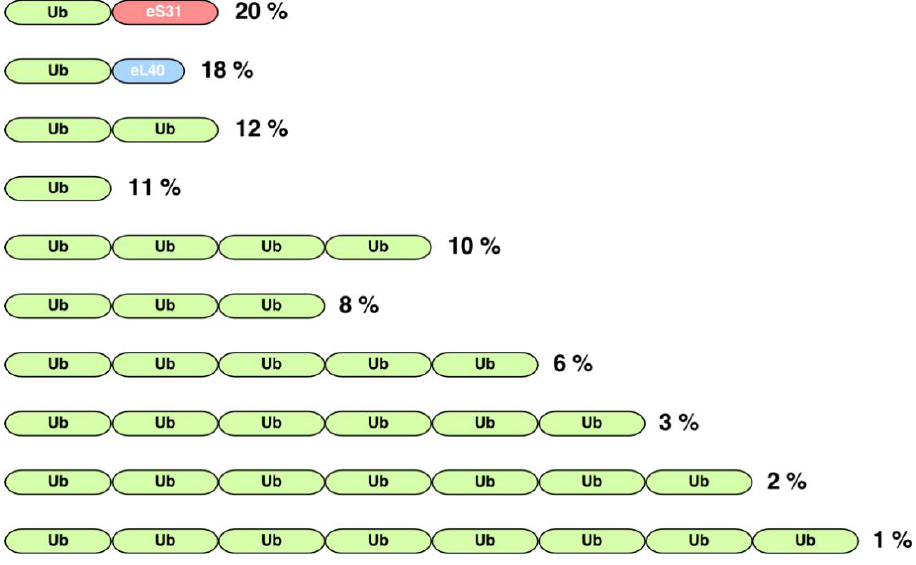
Figure 2. Schematic representation of the organization of the 10 most common protein architectures containing the ubiquitin domain (PFAM entry PF00240). Green blocks represent the ubiquitin sequence. Red and blue blocks represent the characteristic domains of the eS31 (PFAM PF01599) and eL40 (PFAM PF01020) family of ribosomal proteins, respectively. Note that the shown architectures comprise about 92% of all ubiquitin-containing proteins. Numbers on the right indicate the percentage of a particular architecture among all analyzed proteins. As described in the text, this analysis was carried out with all those proteins of the PF00240 entry that showed more than 80% identity over at least 80% of their length with the Ub domain of S. cerevisiae .